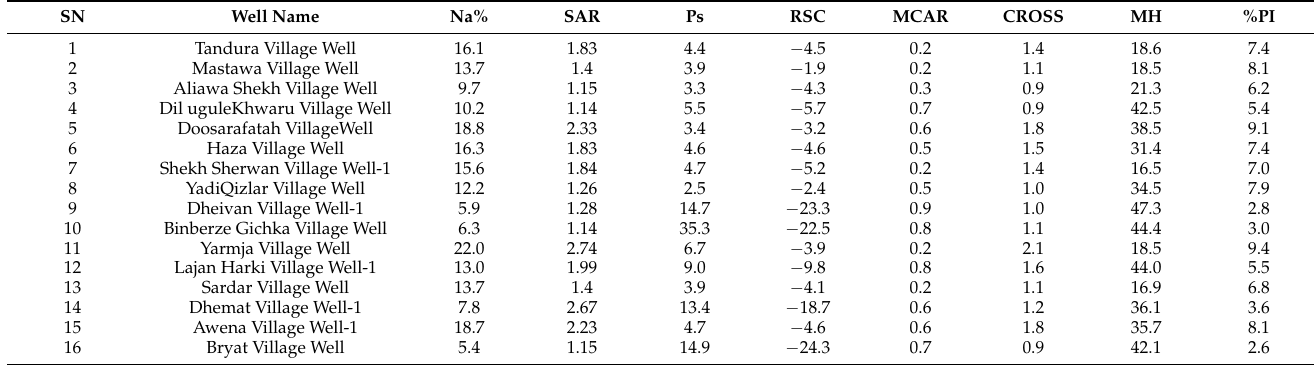
Table A1. Calculated parameters of irrigation water quality in the study area.